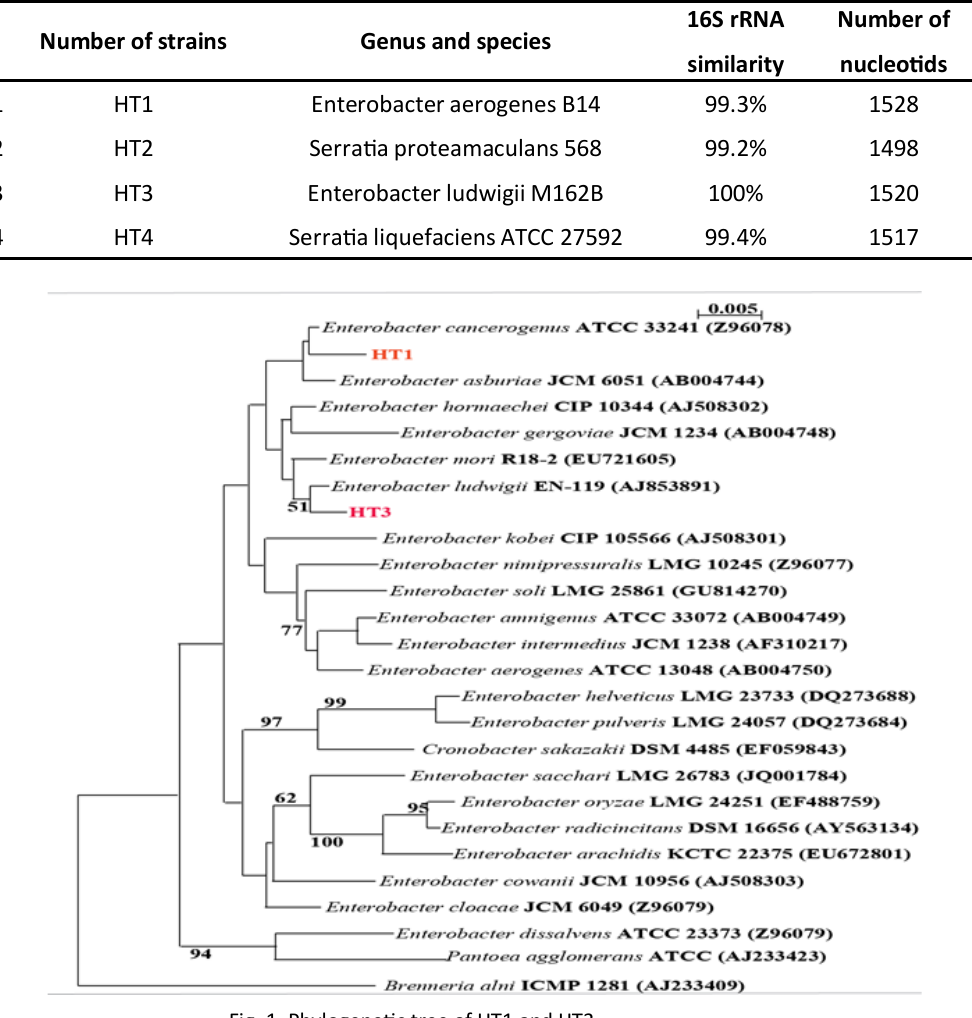
Table 1. Phylogenetic analysis of 16S rRNA gene sequence